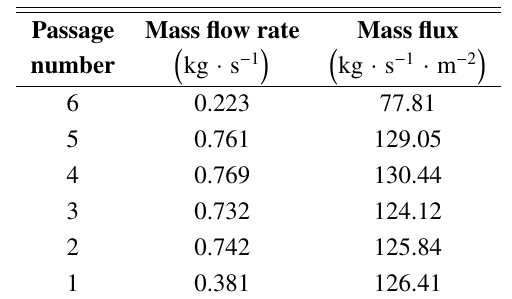
Table 1: Mass flow rate through the individual inter-blade passages.